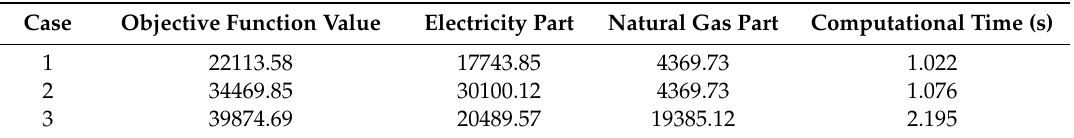
Table 8. Objective function value in the three cases.